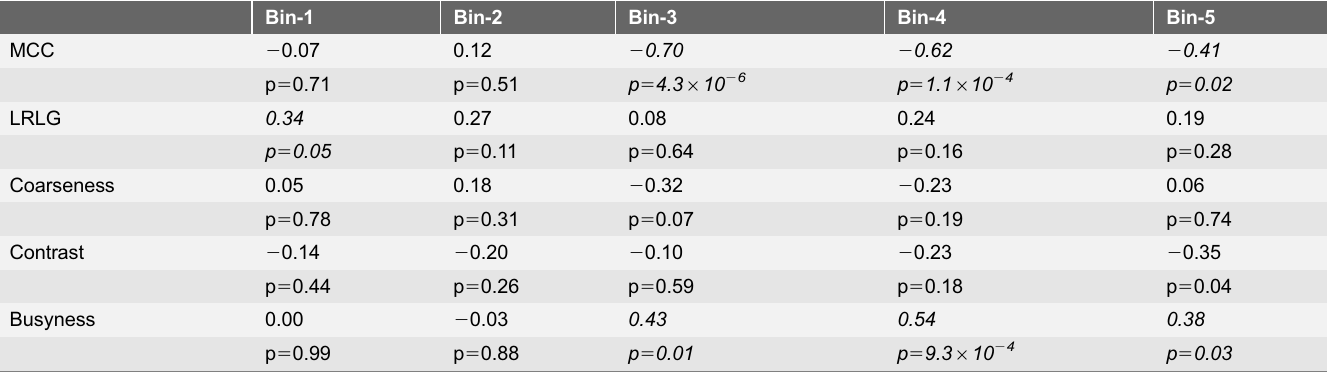
Table 2. Spearman correlation coefficient of Amplitude:ATV (mm 2 2 ) and d 3D-4D and its